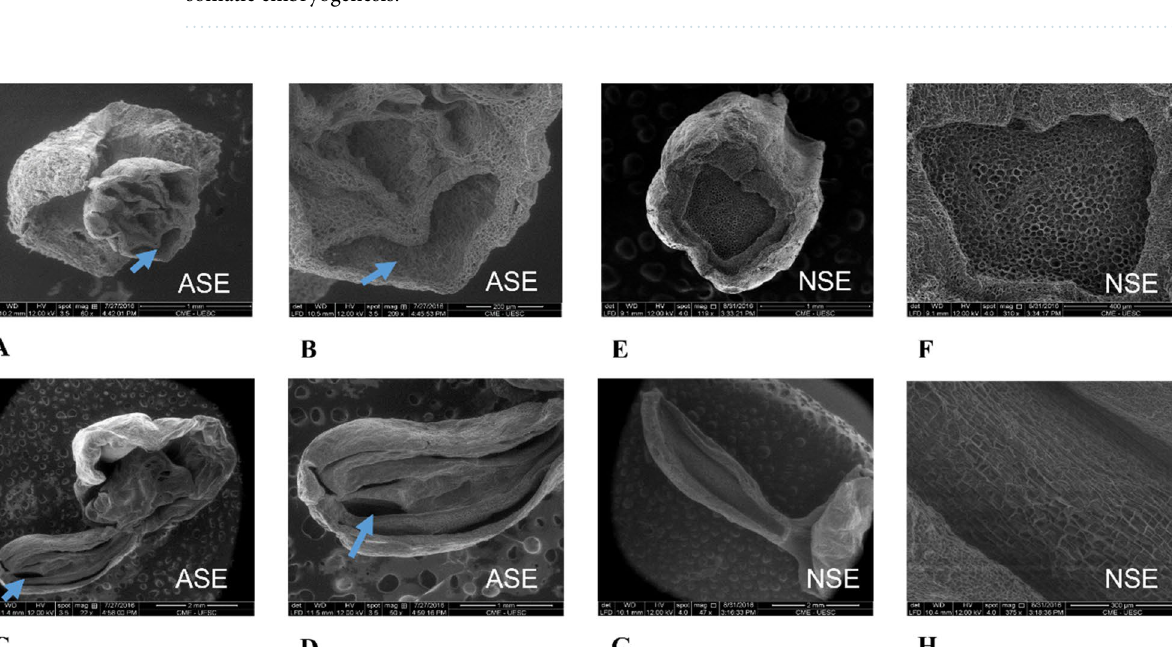
Table 1. Number of normal and abnormal somatic embryos and percentage in primary and secondary somatic embryogenesis.